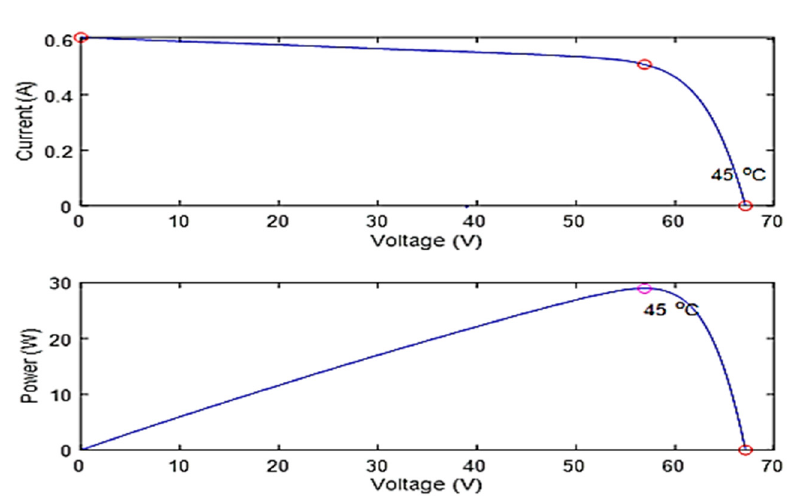
Figure 16. V-I and P-I characteristics at 40 °C.